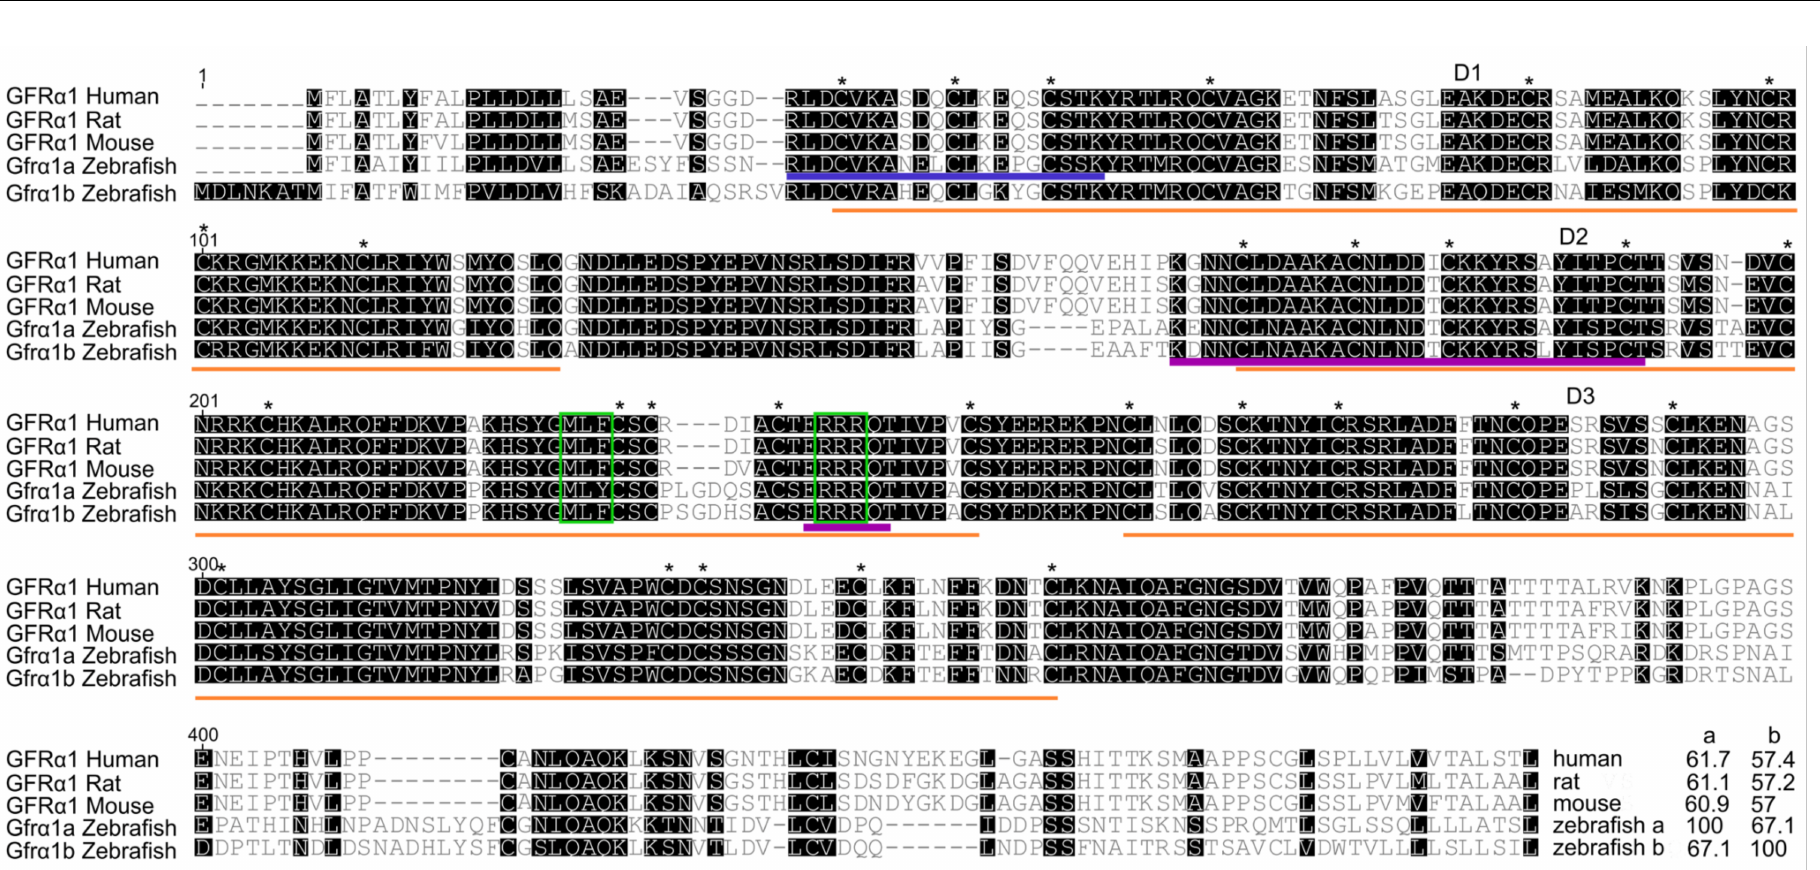
Figure 1. GFR α 1 predicted amino acid sequence alignment. Numbers at the top left of the sequences indicate amino acid positions, dashes indicate deletions and black boxes indicate shared sequences. The three cysteine-rich domains (D1–D3) (orange lines), 28 cysteine residues (*) (plus 2 in the terminal region) and two triplets (MLF and RRR) (green boxes) are highly conserved among humans, rodents and zebrafish. At the end of the alignment are the percentage identity values of zebrafish Gfr α 1a and Gfr α 1b in relation to the other corresponding sequences. The blue line indicates the amino acid sequence recognized by the zebrafish Gfr α 1a antibody used in this study; the purple line indicates the putative motifs critical for binding to